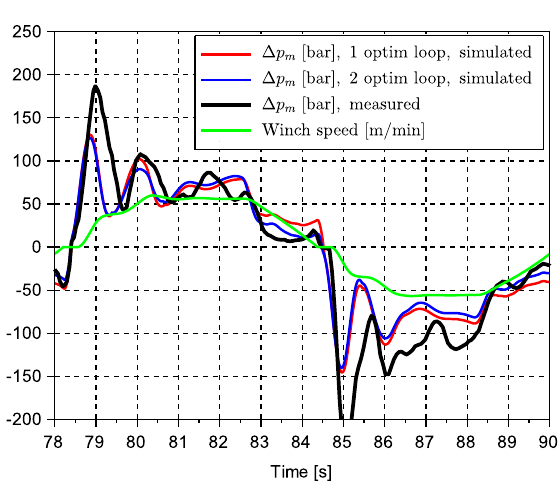
Figure 15: Measured and simulated pressure drop.